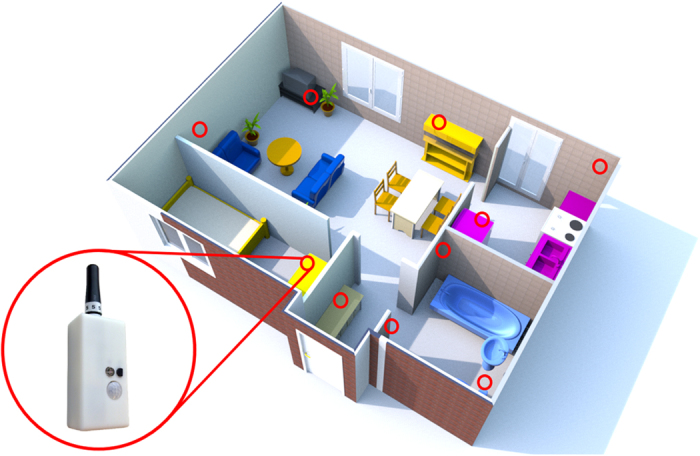
Floor plan of an apartment showing placement of sensor boxes (red circle).Each sensor box (inset photo) captures light, temperature, humidity, movement and acceleration. The floor plan was created using Sweet Home 3D version 5.2a. Sweet Home 3D, Copyright (c) 2005–2016 Emmanuel PUYBARET/eTeks <  info@eteks.com >.